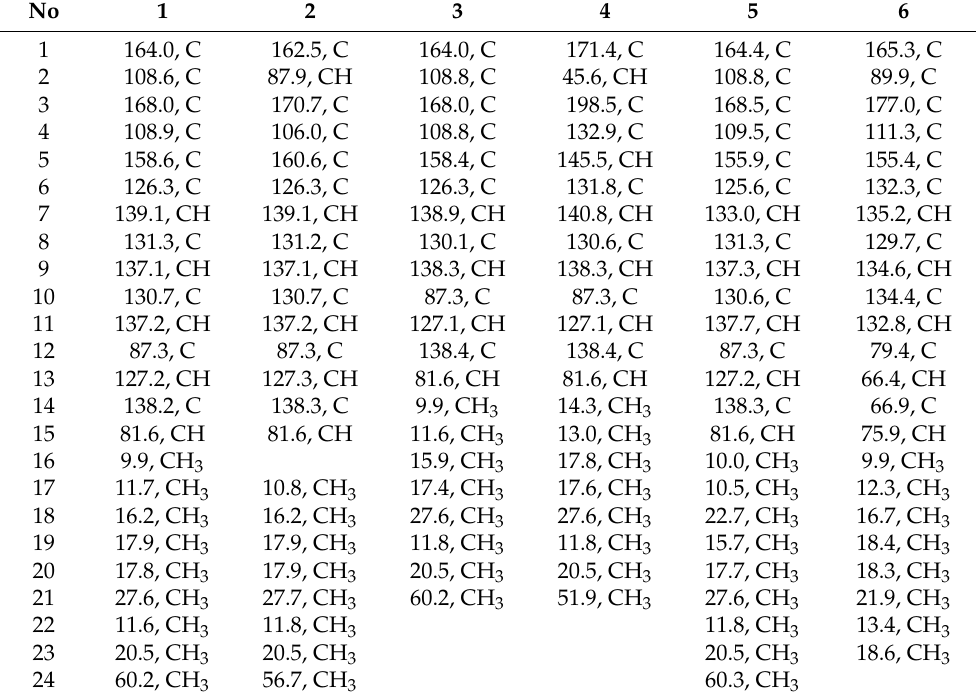
Table 2. 13 C-NMR Data of Compounds 1 – 6 (125 MHz, DMSO- d 6 , δ in